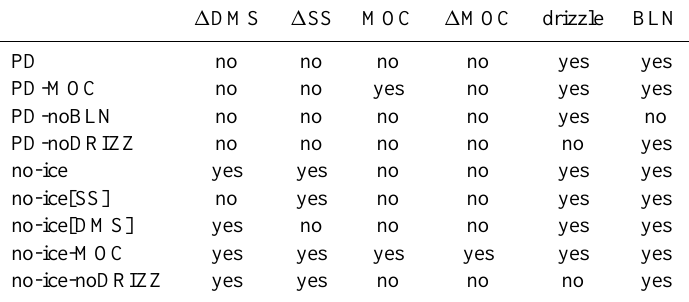
Table 1. Summary of processes included in model simulations: 1 DMS (DMS flux response to sea-ice loss), 1 SS (sea-salt flux response to sea-ice loss), MOC (primary marine organic flux), 1 MOC (MOC flux response to sea-ice loss), drizzle (stratocumulus scavenging) and BLN (boundary layer